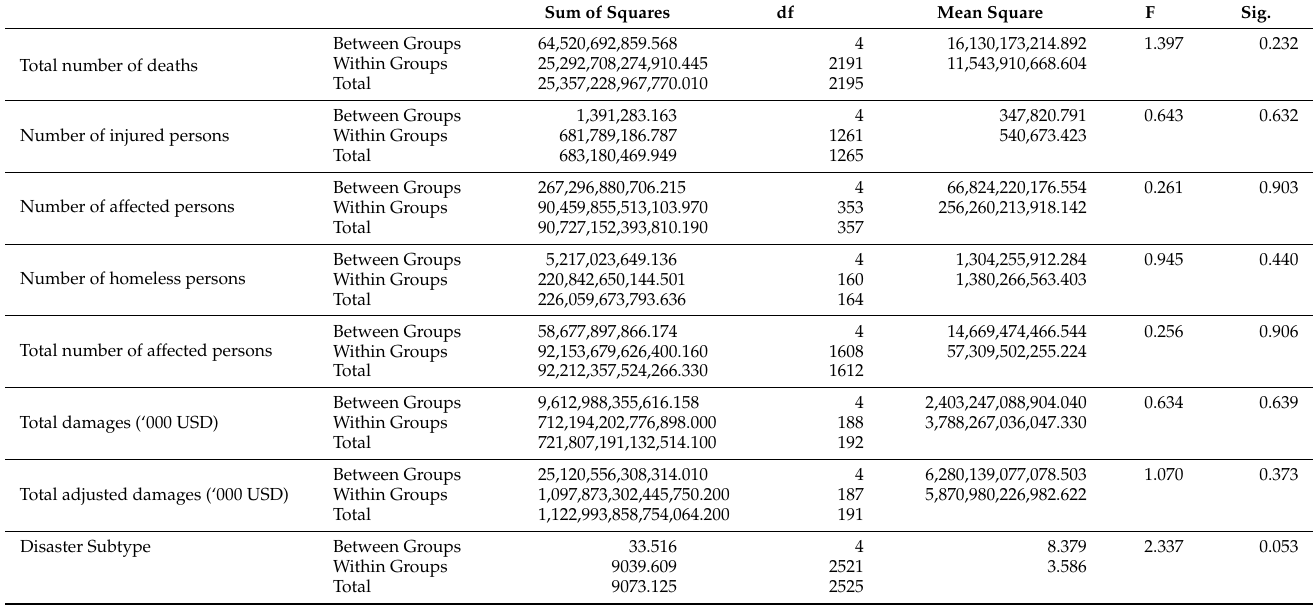
Table 4. The results of One-way ANOVA test for groups by location of the event. Sum of Squares df Mean Square F